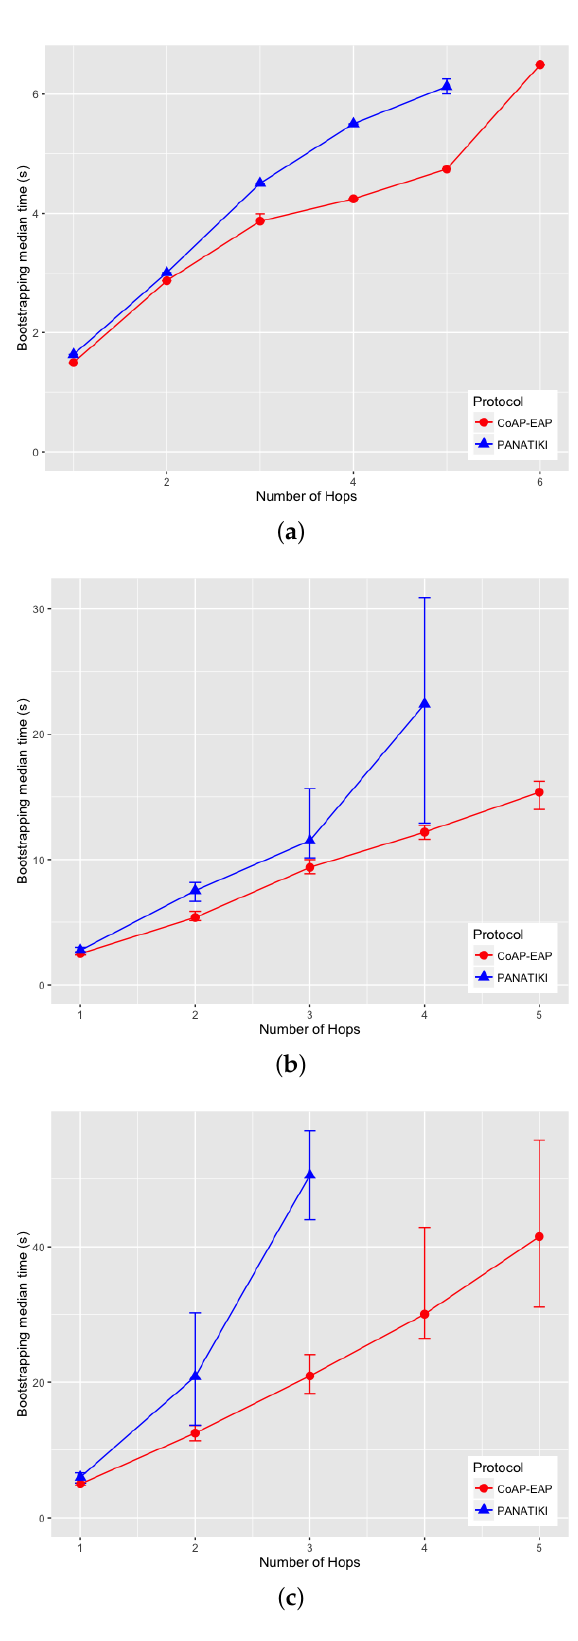
Figure 9. Bootstrapping median Time. ( a ) Bootstrapping Median Time with 0.0 loss ratio; ( b ) Bootstrapping Median Time with 0.1 loss ratio; ( c ) Bootstrapping Median Time with 0.2 loss